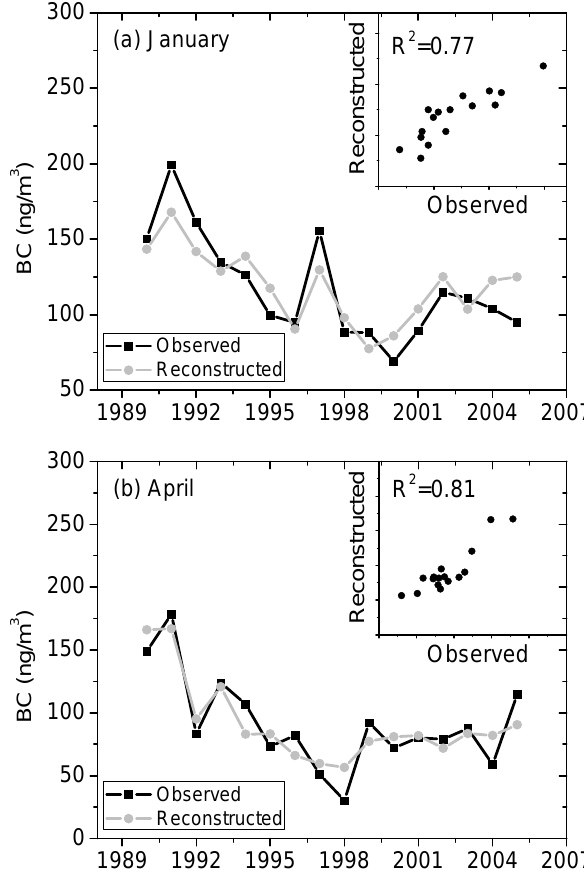
Fig. 3. Time-series of the model reconstructed and the observed monthly average BC concentrations in January (a) and April (b) , 1990–2005. The R 2 shown in both plots are the squares of the Pearson’s correlation coefficients between the reconstructed and ob- served BC concentrations rather than those for linear